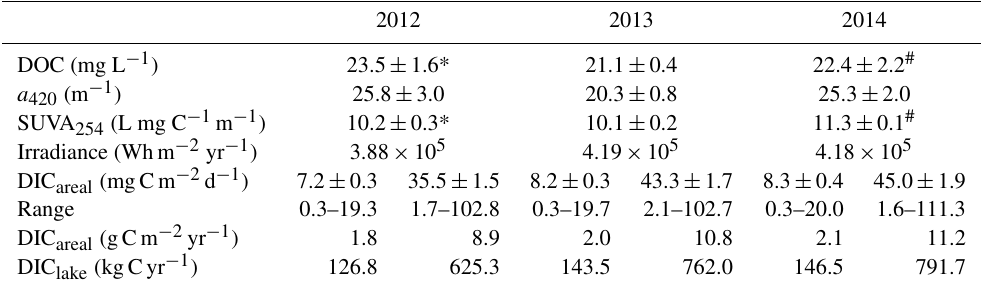
Table 2. Mean ( ± SE) background variables ( n = 8 in 2012 and 2014, n = 12 in 2013), and simulated irradiance and photochemical DIC production rates assuming the lowest (left) and the highest (right) photochemical reactivity measured in